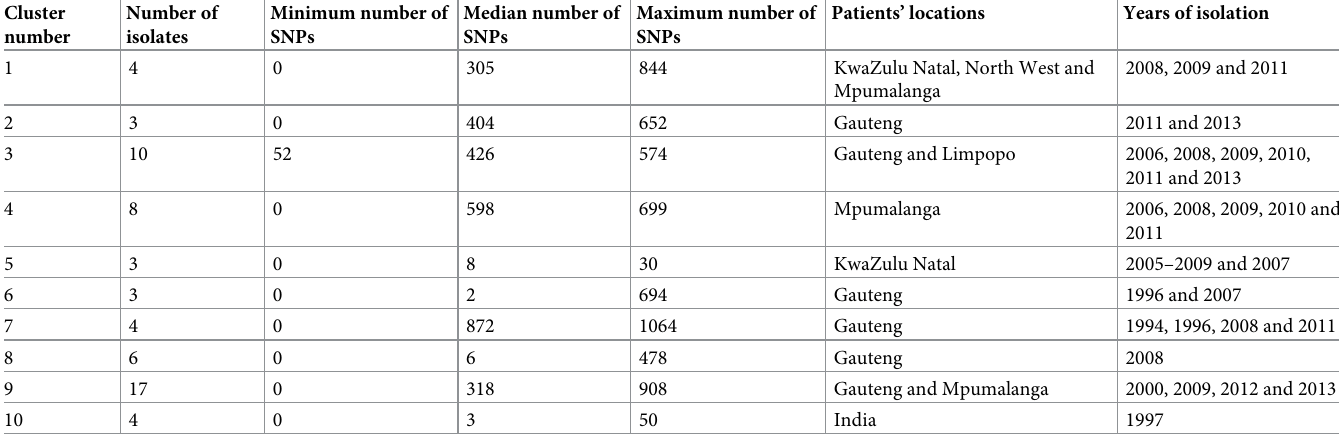
Table 2. Description of clusters of Cryptococcus gattii VGIV isolates from the WGS SNP analysis shown in Fig 2. Cluster Number of number